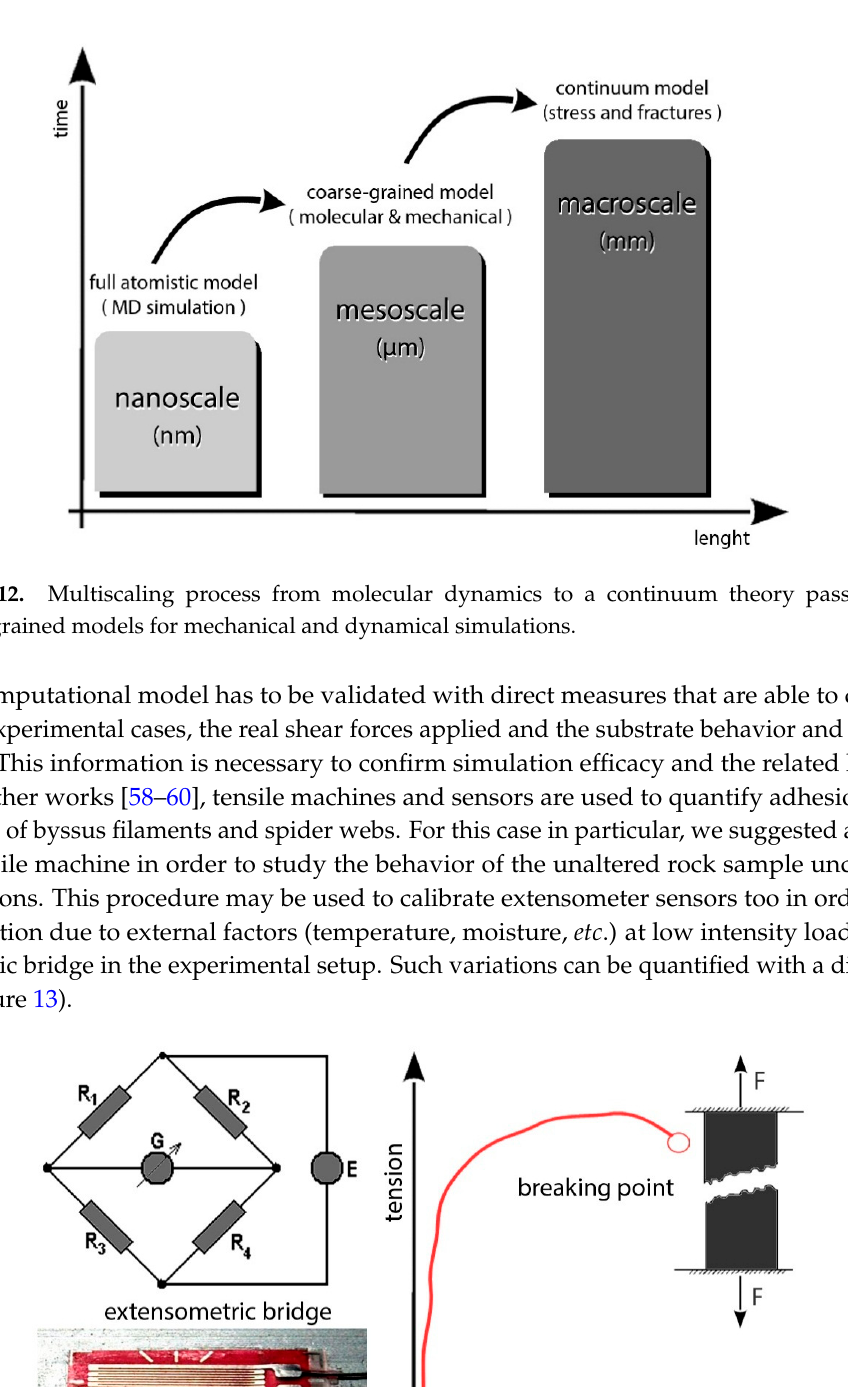
Figure 14. Low ‐ intensity compressive test measures required for the calibration of Equotip L values. After sensor calibration, it is possible to proceed with the validation test under stress conditions (changing moisture levels) for the colonized sample; slices of progressive thicknesses are tested in order to evaluate the magnitude order and the maximum depth penetration of the forces acting on the colonized surface, which are necessary to interpolate a mean surface deformation value (Figure 15).